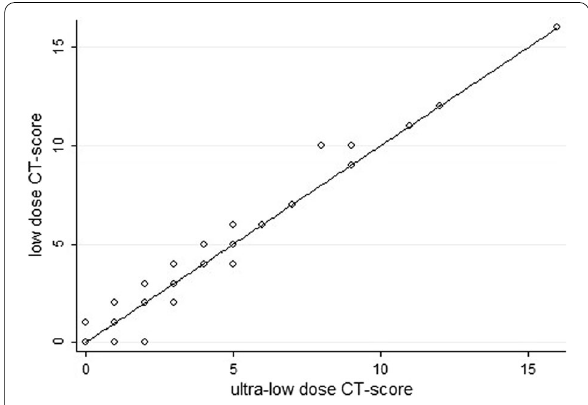
Fig. 5 Passing–Bablok regression method to assess agreement between low‑dose and ultra‑low‑dose of CT‑score. Linearity Test (Test for deviation from linearity) had P > 0.20 and Passing‑Bablok line was “ Y X ”, with the R ‑square of 0.99 =